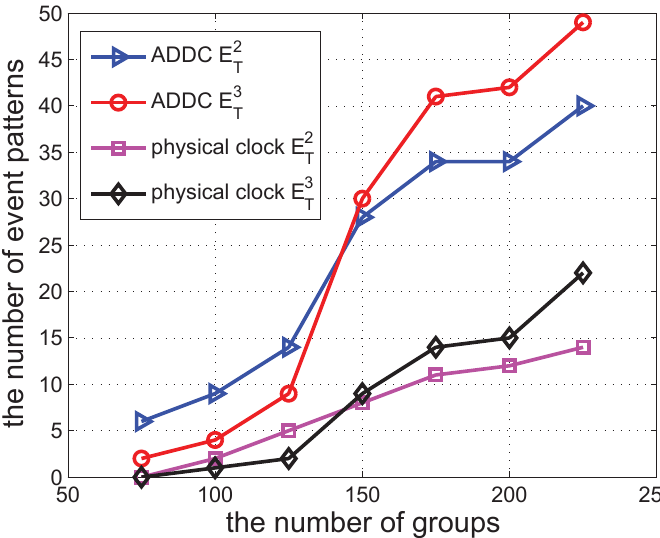
Figure 6. The number of event patterns vs. the number of